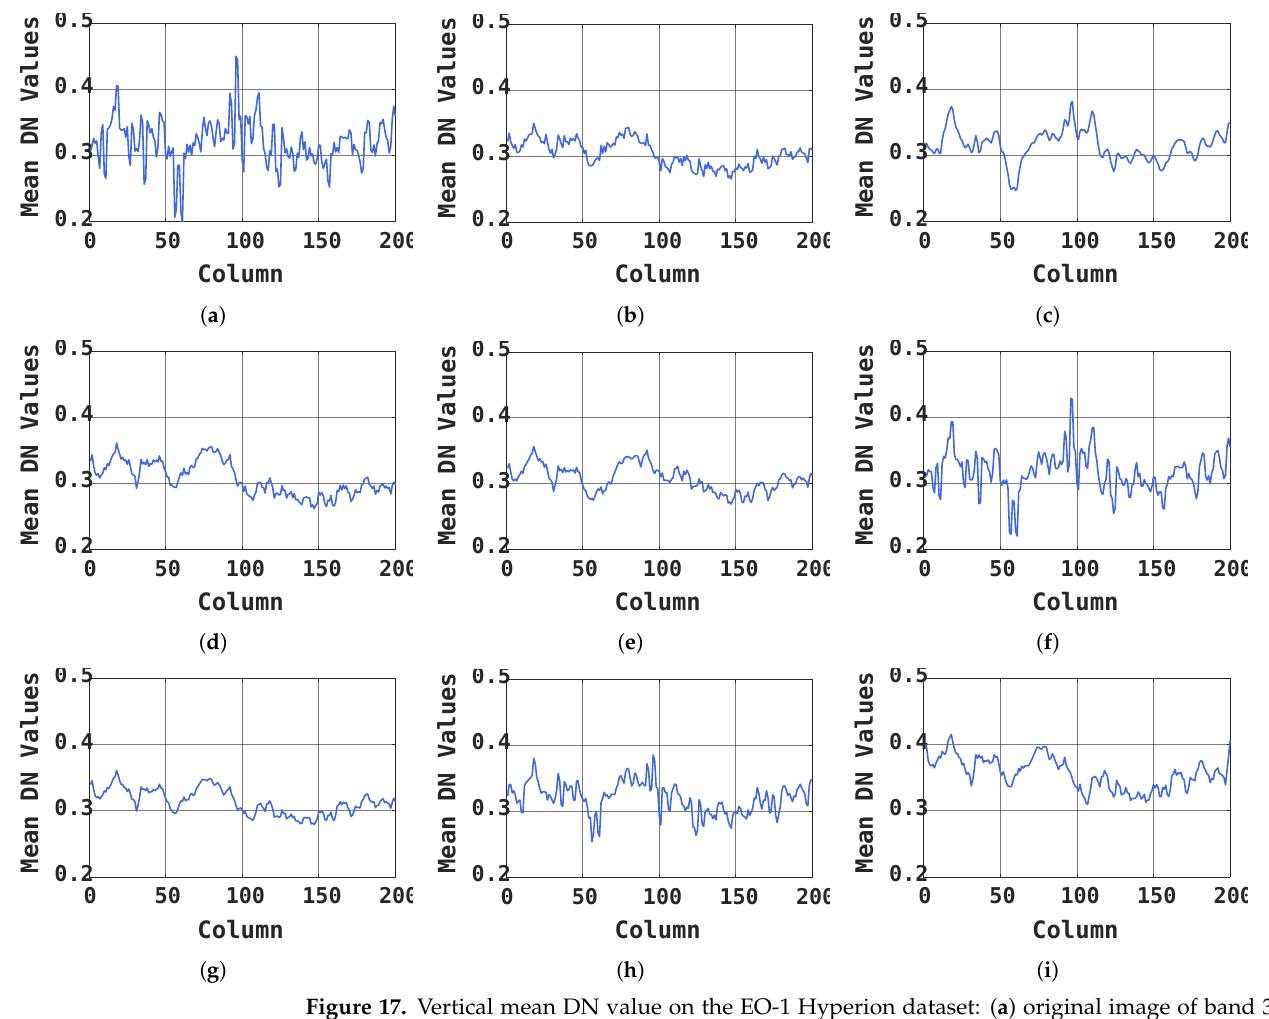
Figure 17. Vertical mean DN value on the EO-1 Hyperion dataset: ( a ) original image of band 36; ( b ) NNM; ( c ) BM4D; ( d ) WNNM; ( e ) WSNM; ( f ) LRTDTV; ( g ) 3DTV; ( h ) FastHyDe; and ( i ) the proposed